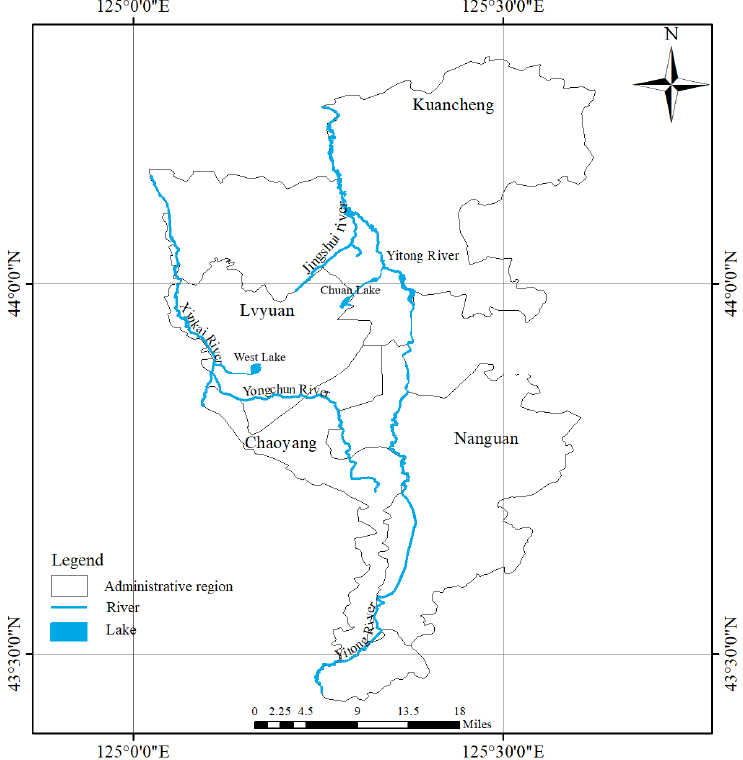
Figure 1. Map of river distribution in Changchun City.